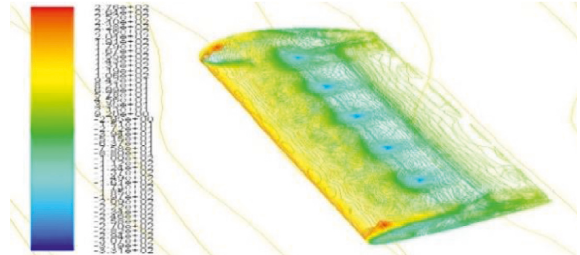
Figure 11: Total pressure at 0 ° AOA for the 2nd module.